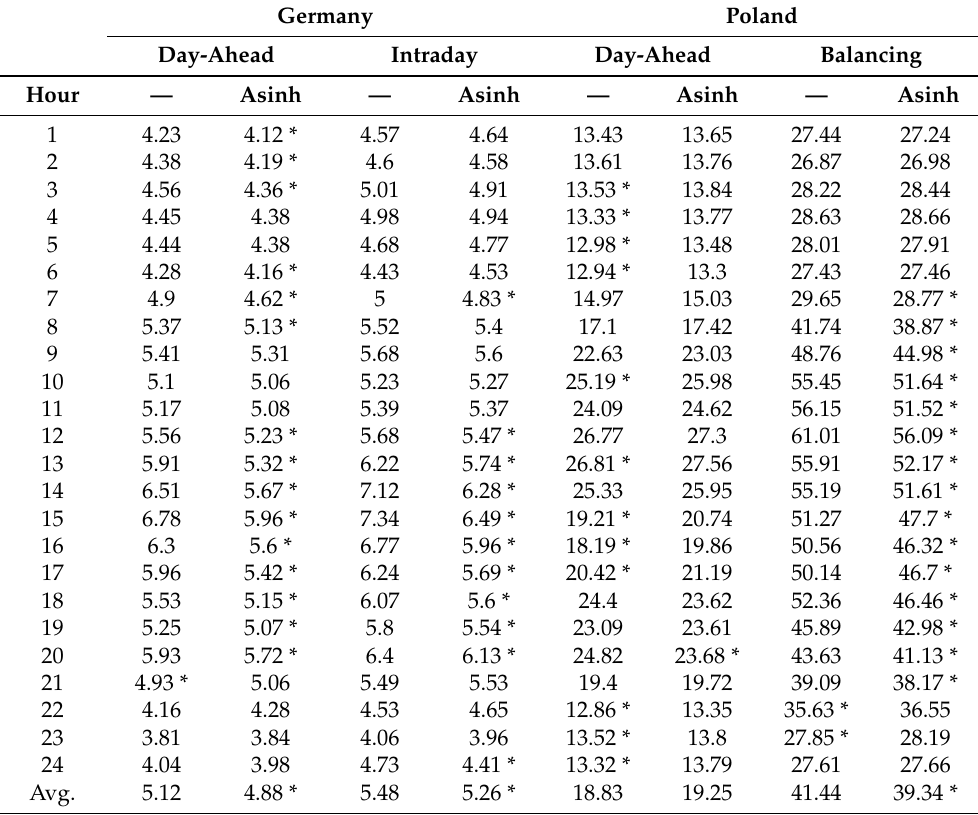
Table 3. Mean absolute error (MAE) of hourly point forecasts obtained from the ARX model fitted to prices as well as prices transformed using asinh function. The unit of MAE is EUR/MWh and PLN/MWh for Germany and Poland, respectively. For each market, each hour as well as their hourly average (last row) significantly lower values according to the Diebold–Mariano test calculated at 5% significance level are denoted by